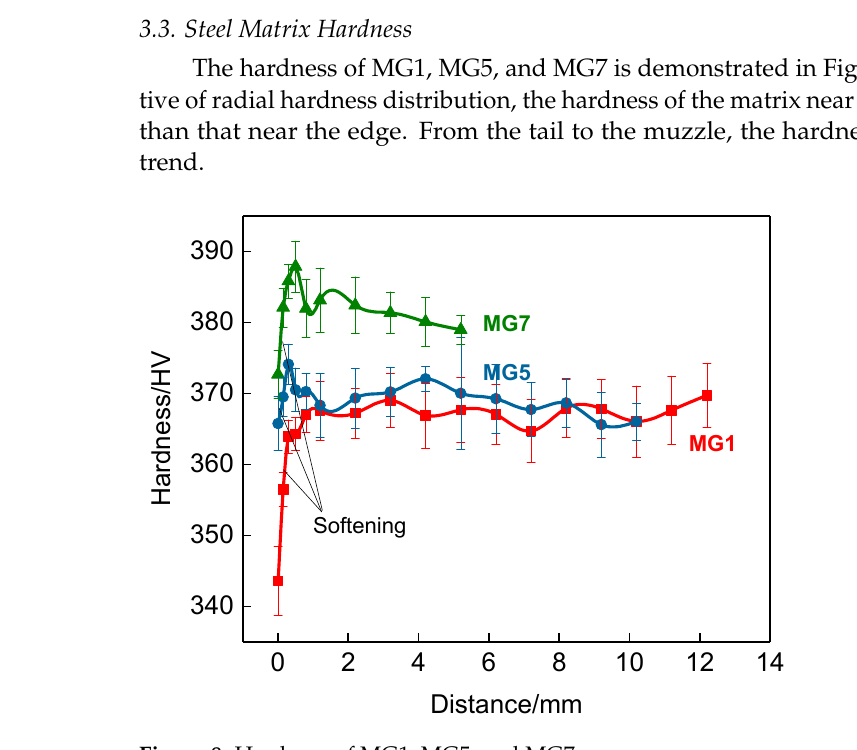
Figure 7. Cross-sectional SEM morphology of MG7.